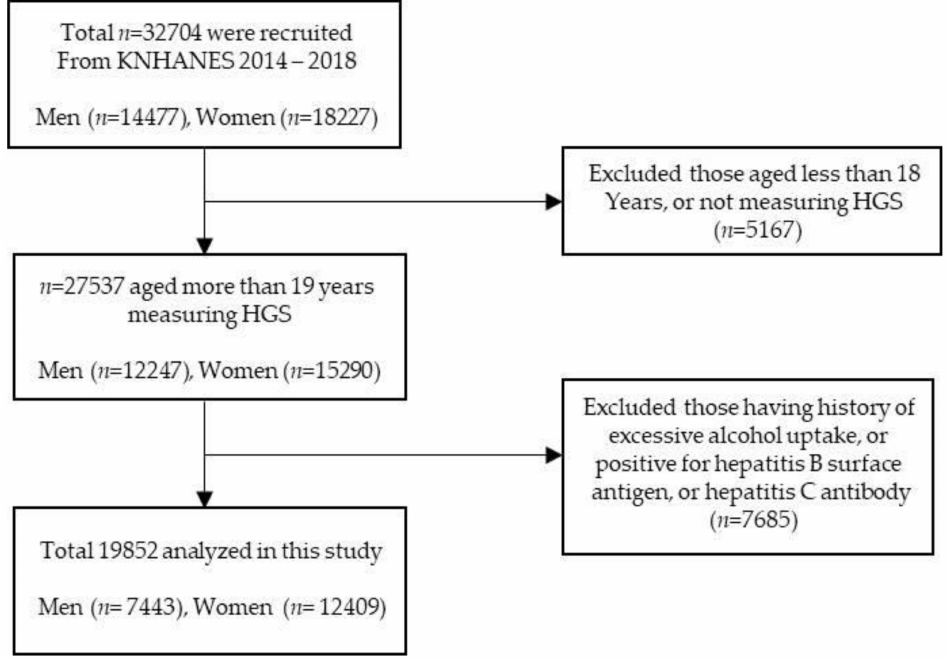
Figure 1. Flow chart of the study population